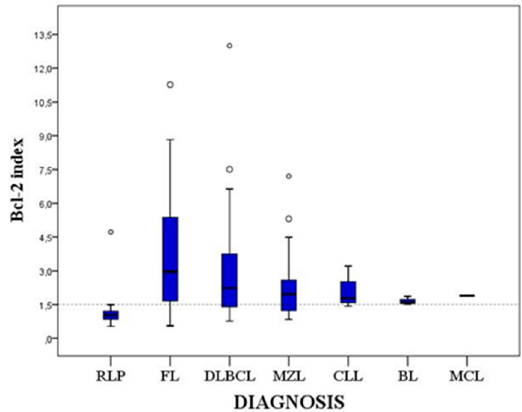
Figure 1. Quartile diagram of Bcl-2 indexes in RLP and various BCL types. The Bcl-2 index of 1.5 is shown with a dotted line. RLP—reactive lymphocytic proliferation. FL—follicular lymphoma. DLBC—diffuse large B-cell lymphoma. MZL—mantle zone lymphoma. CLL—chronic lymphatic leukaemia. BL—Burkitt lymphoma. MCL—mantel cell lymphoma.